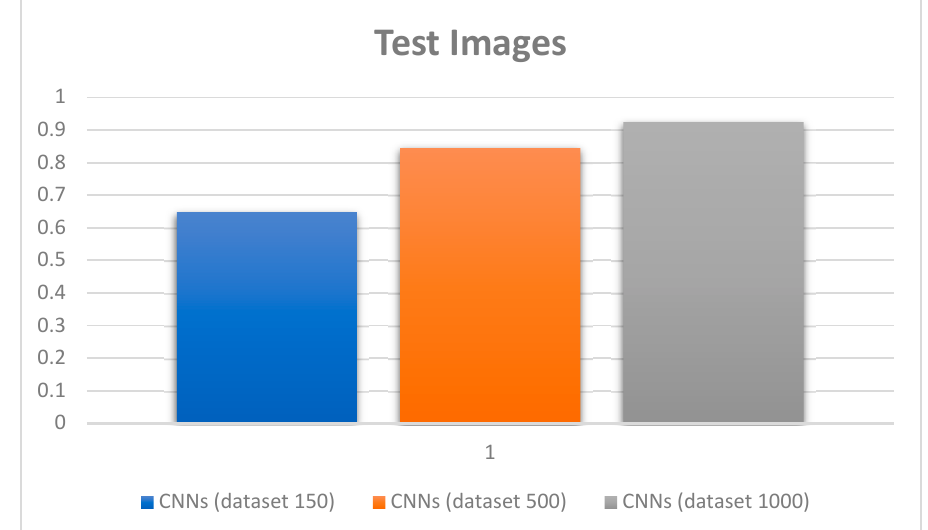
Figure 14. Graph of mean reliability for all three trained networks.